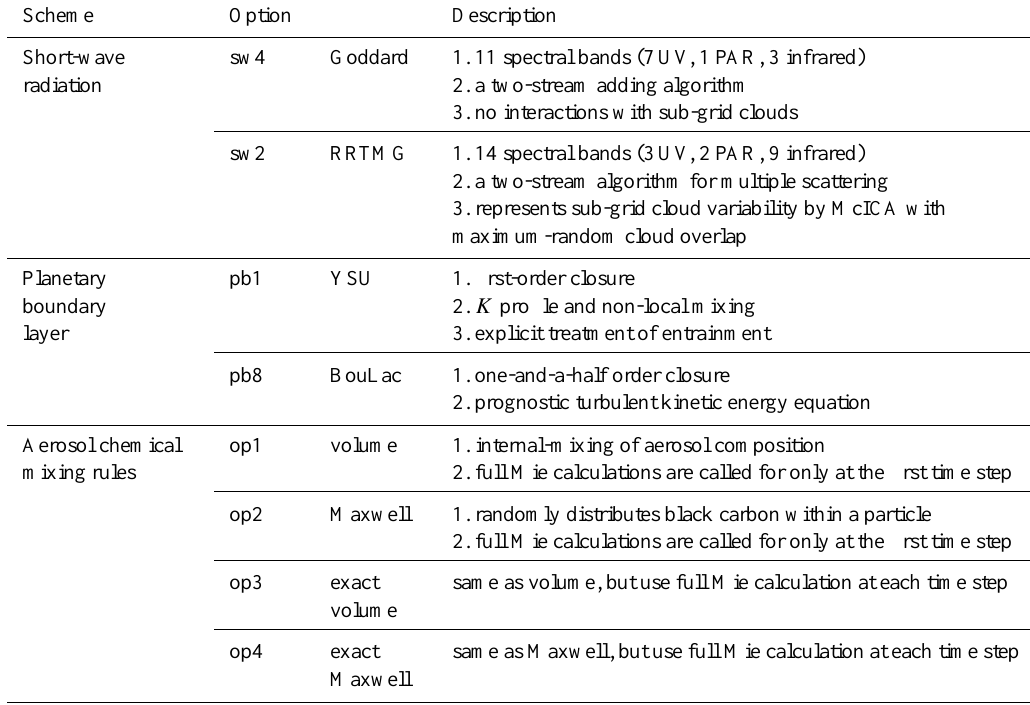
Table 2. Various schemes employed to create the ensemble members.